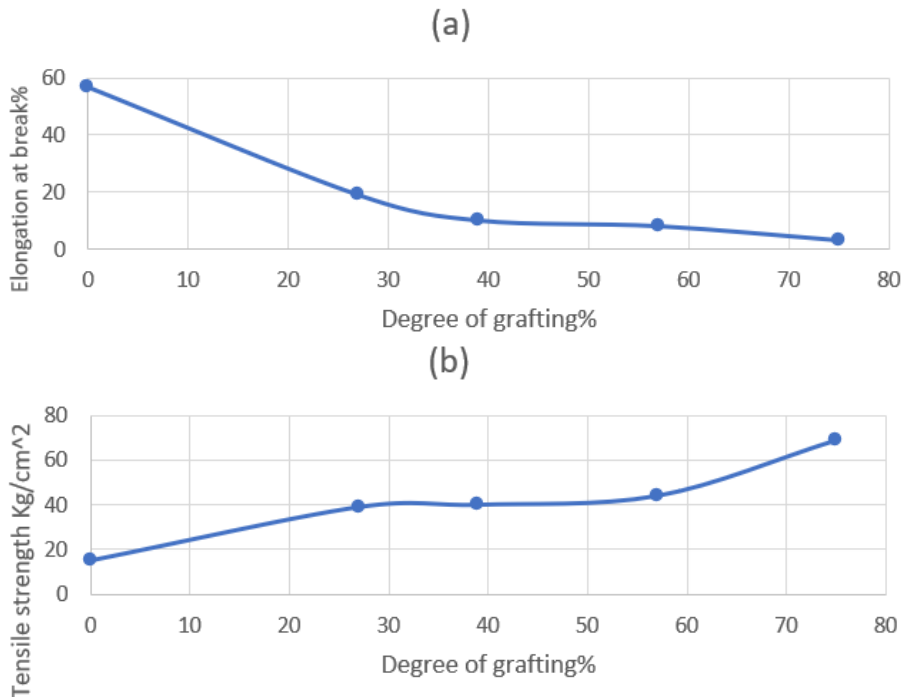
Figure 7. Effect of the degree of grafting on ( a ) the tensile strength and ( b ) the % elongation at the break on PP.